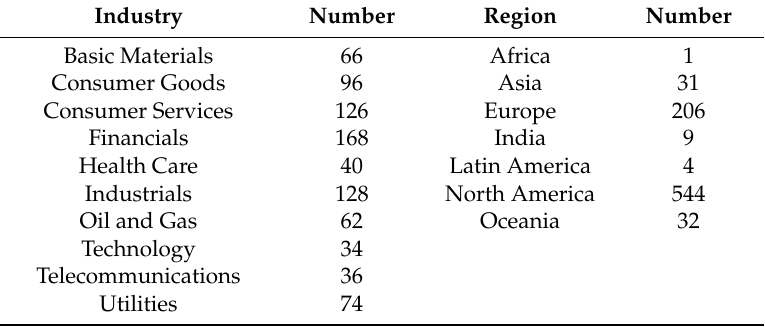
Table 1. Credit breakdown by industry and region 1